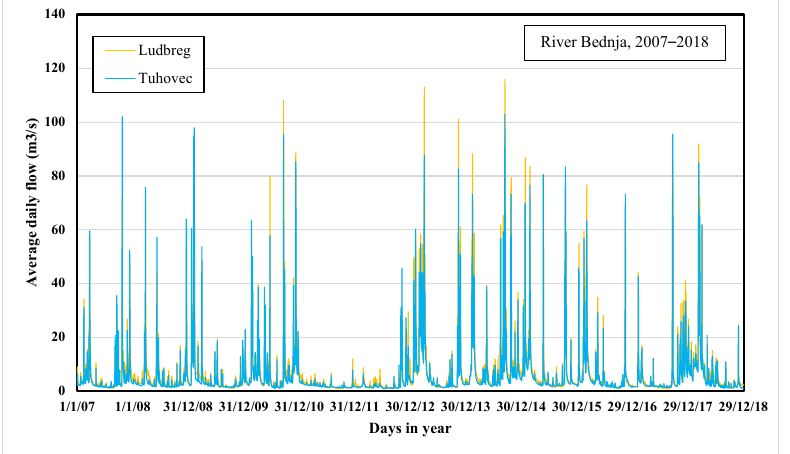
Figure 10. Comparison of the average daily flows for the measuring stations Ludbreg and Tuhovec.